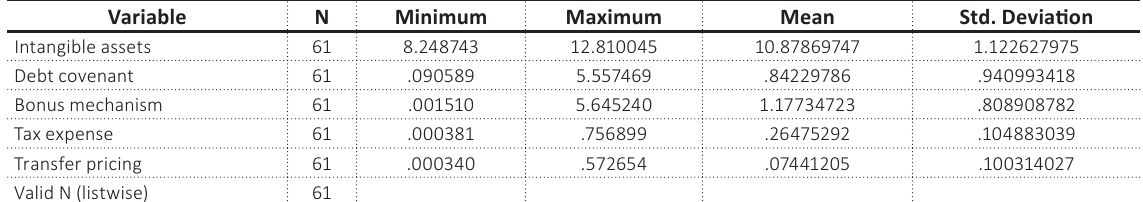
Table 3. Descriptive statistical